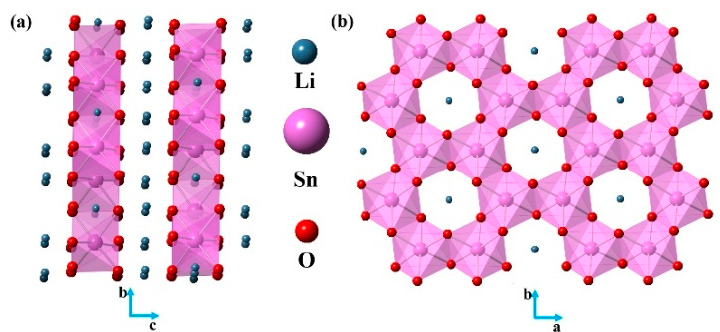
Figure 1. ( a ) Schematic image of Li 2 SnO 3 viewed along a direction and ( b ) [Li 1/3 Sn 1/3 O 2 ] layer structure (planar projection along c direction).